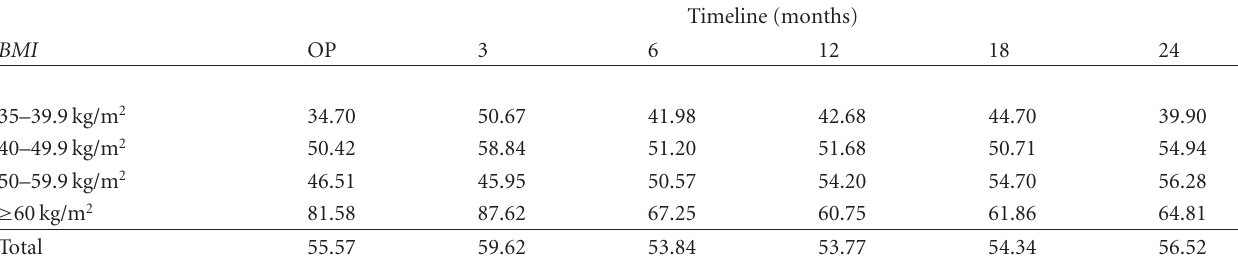
Table 8: Postoperative course of parathormone